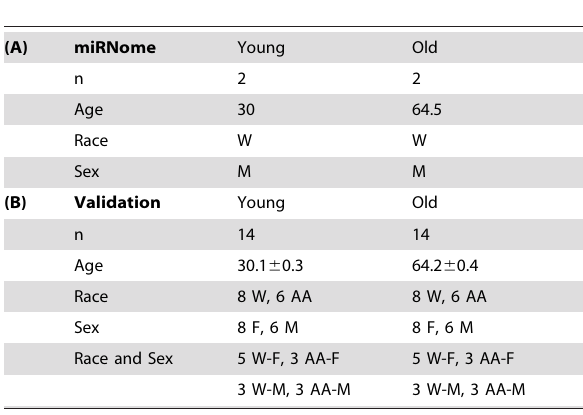
Table 1. Patient demographic